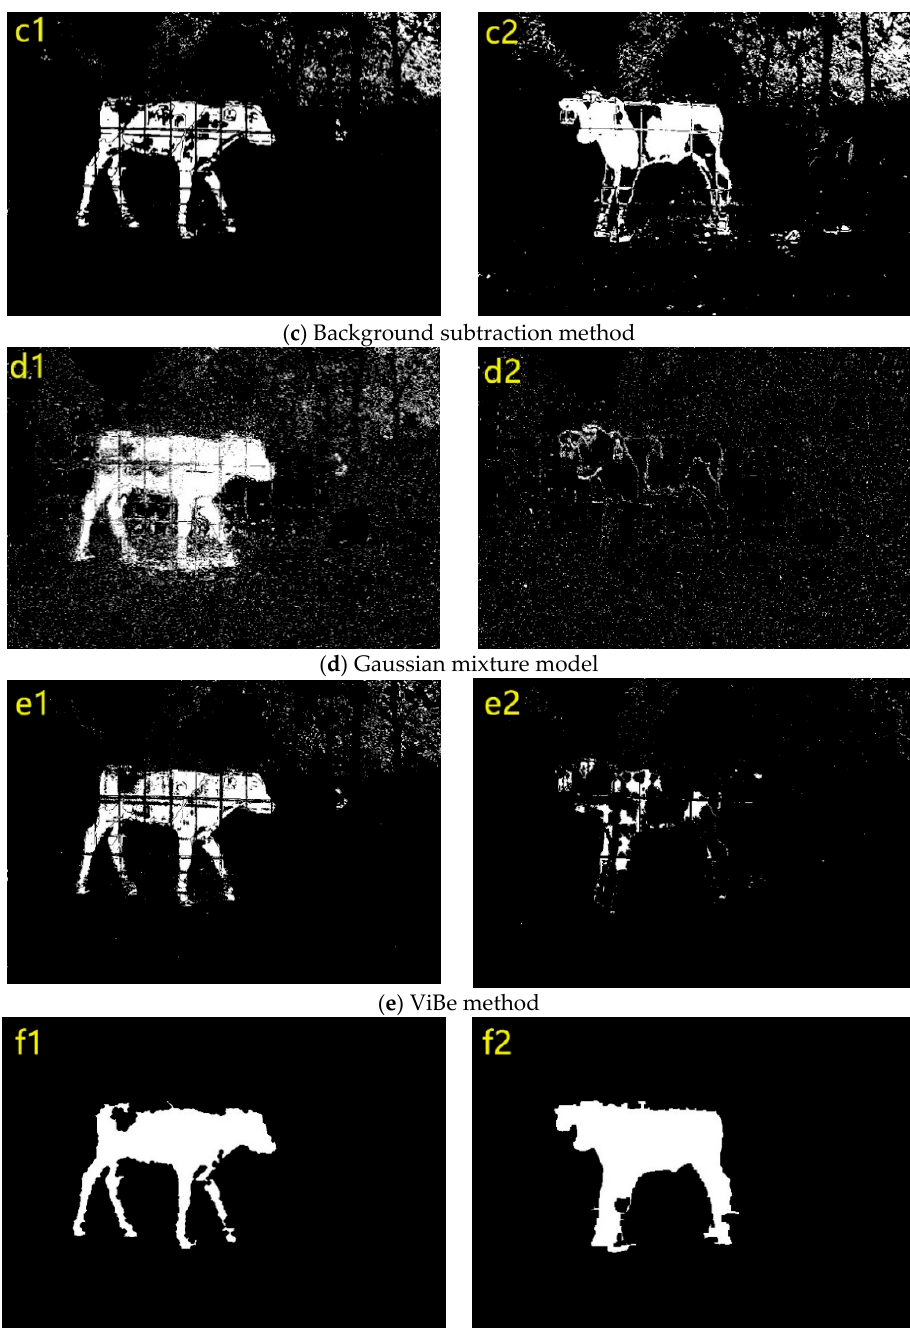
Figure 5. Dairy calf detection with different methods. The left column shows the detection results of different methods of calves in motion. The right column is the detection results of different methods of calf in stationary. b – f corresponds to the detection results of the frame difference method, background subtraction method, gaussian mixture model, ViBe, and the method of this paper.